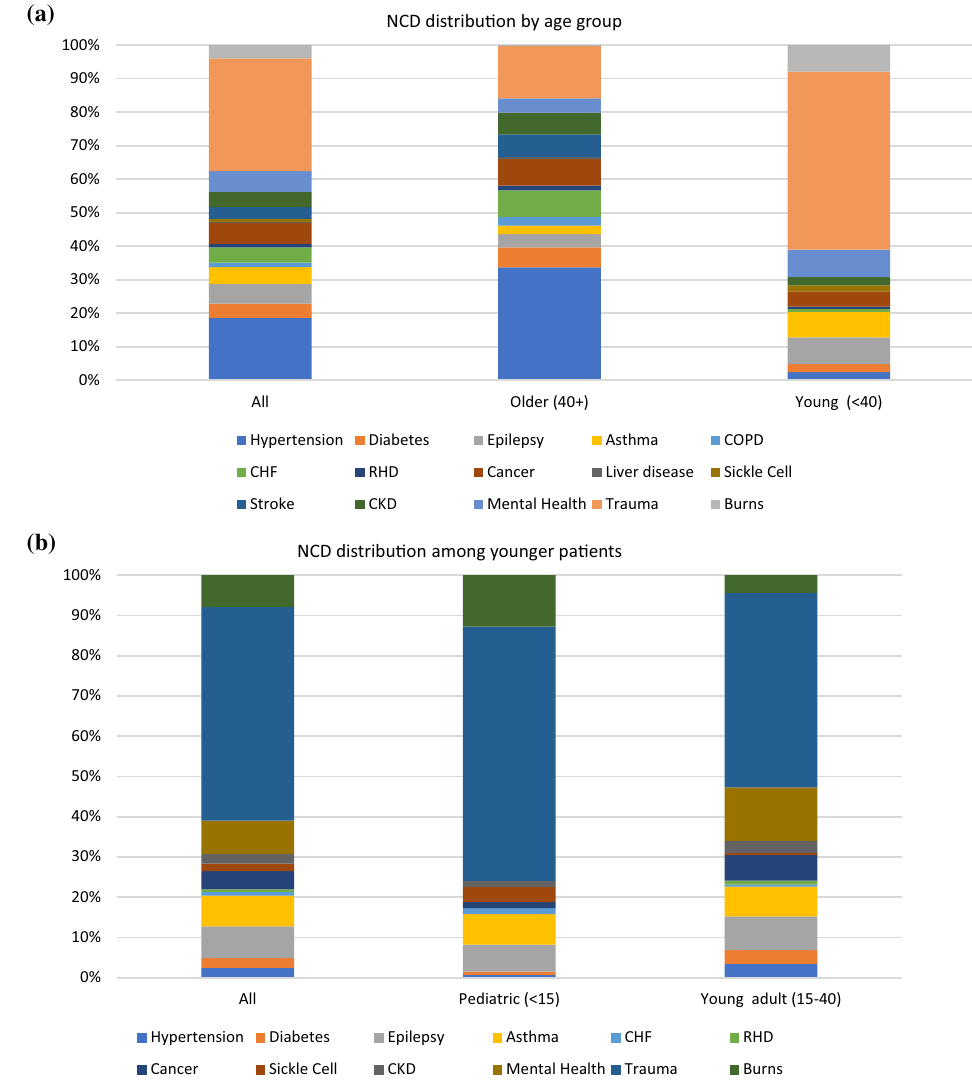
Fig. 1 a Non-communicable disease distribution by age group. Percent distribution of each NCD among total NCD diagnoses, broken down for all patients, patients 40 years and older, and patients under 40 years of age. NCD Non-communicable disease, COPD Chronic obstructive pulmonary disease, CHF Congestive heart failure, RHD Rheumatic heart disease, CKD Chronic kidney disease. b Non-communicable disease distribution among patients under 40 years of age. Percent distribution of each NCD among total NCD diagnoses, broken down for all patients under 40 years of age, patients under between 15 and 40 years of age, and patients under 15 years of age. NCD Non-communicable disease, CHF Congestive heart failure, RHD Rheumatic heart disease, CKD Chronic kidney